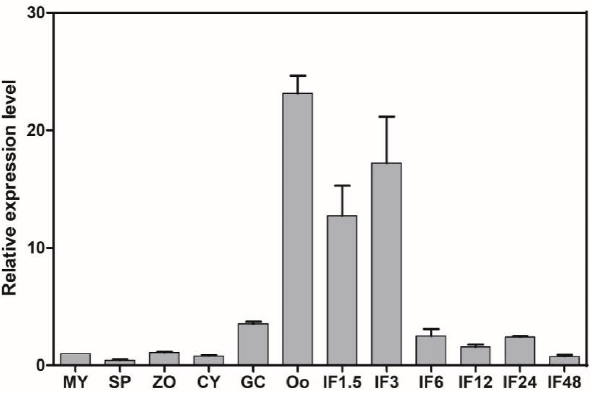
Figure 3. Expression profile PlCZF1 . Relative expression levels of PlCZF1 were determined by qRT-PCR with total RNA extracted from mycelia (MY), sporangia (SP), zoospores (ZO), cysts (CY), germinating cysts (GC) and oospores (Oo), and litchi leaves infected by P. litchii mycelial mats after 1.5, 3, 6, 12, 24 and 48 h (IF1.5 h to IF48 h). The constitutive expression of PlActin was used as reference gene. Expression levels were normalized using the MY values as ‘1’. Data represent means ±SD from three independent biological repeats.